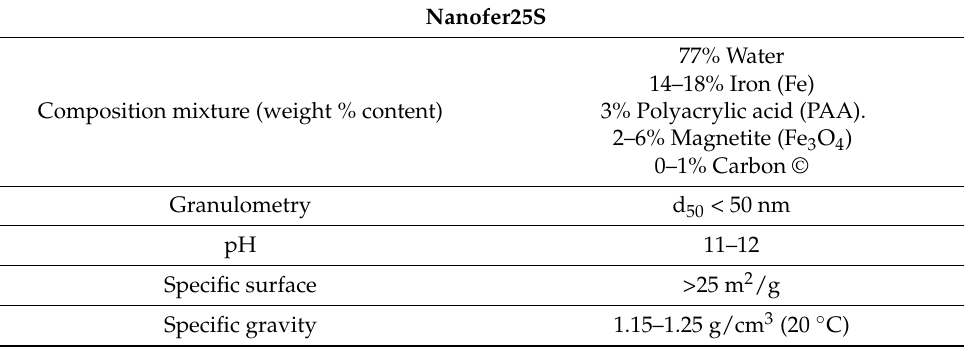
Table 2. Main features of the Nanofer25S solution.